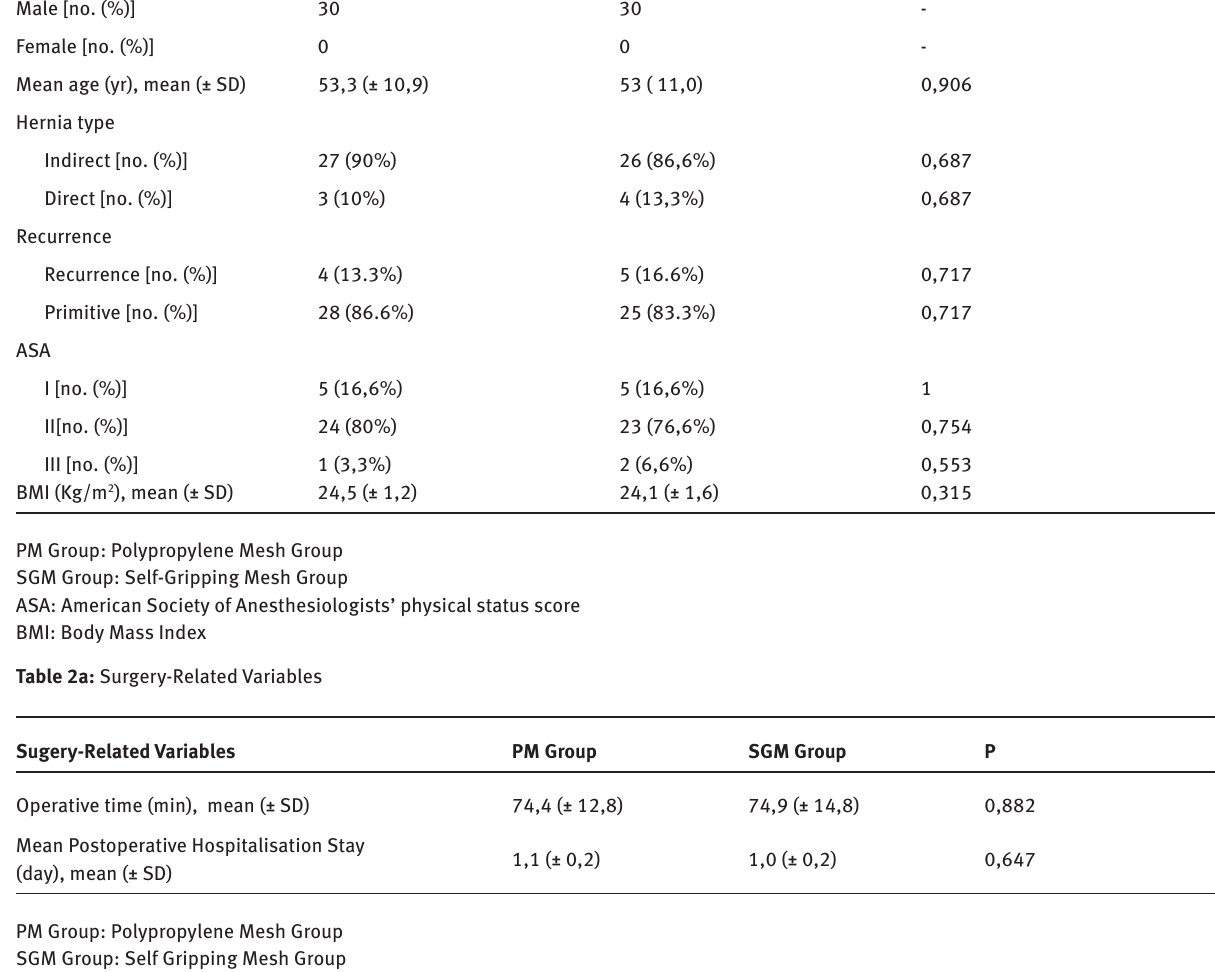
Patient Baseline Characteristics PM Group SGM Group